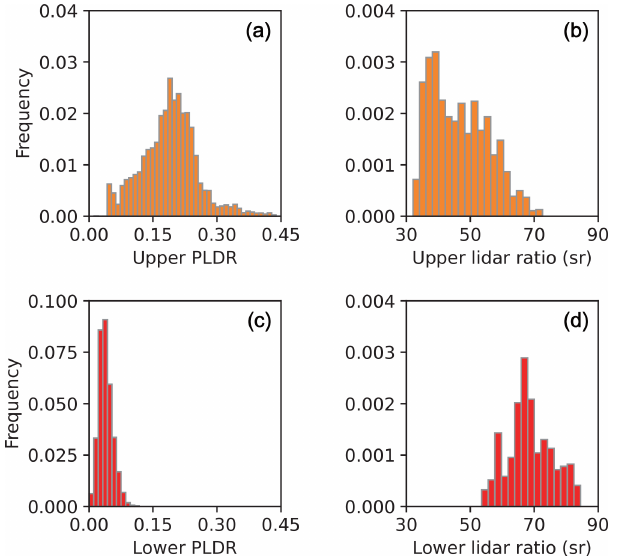
Figure 3. Frequency histogram of RL parameters during HPI 1 and HPI 2. Frequency distributions of (a) the PLDR in the upper lidar layer, (b) the lidar ratio (LR) in the upper lidar layer, (c) the PLDR in the lower lidar layer, and (d) the lidar ratio in the lower lidar layer. The steps of the PLDR and lidar ratio are 0.01 and 2sr, respectively.